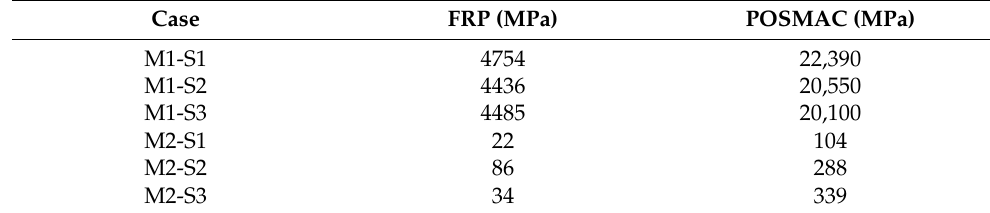
Table 9. Maximum von Mises stress.